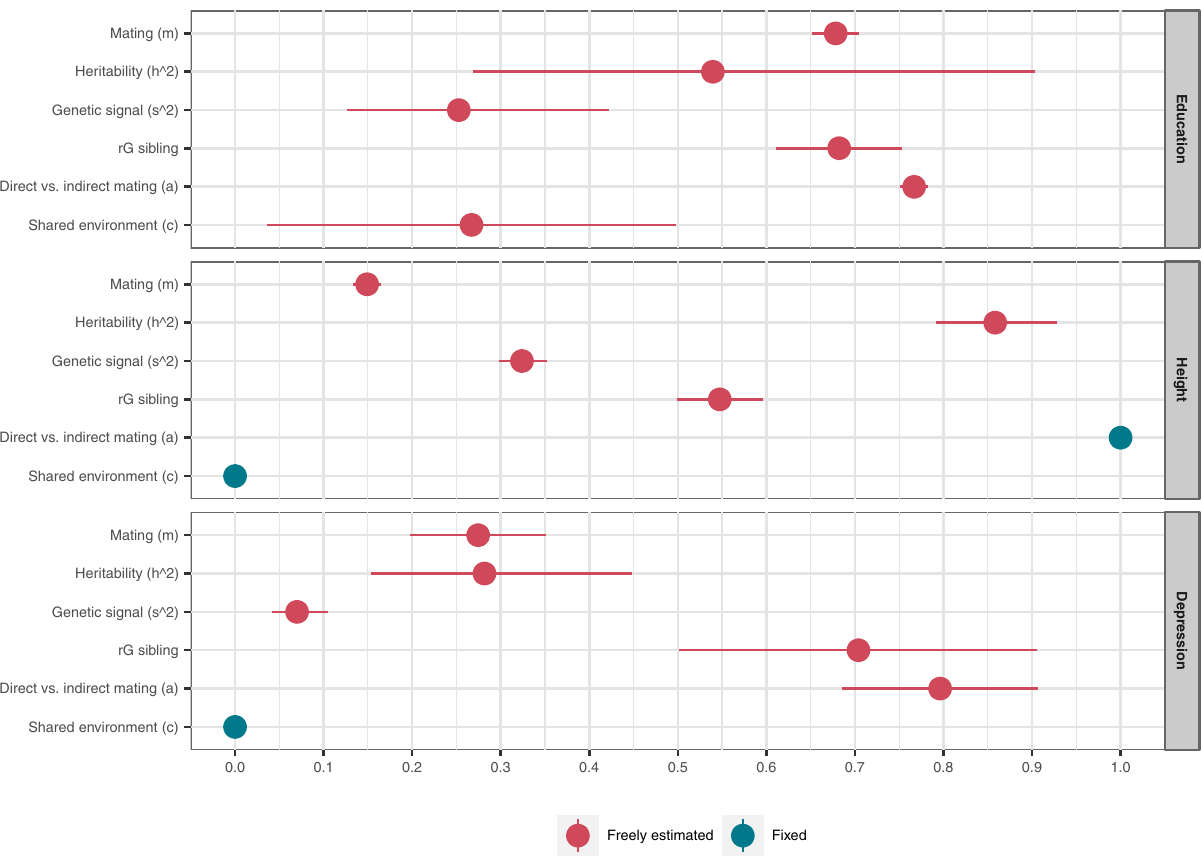
Fig. 3 Parameter estimates. Estimates from the best fi tting rGenSi models, including 95% likelihood-based con fi dence intervals. Values in red are freely estimated and can take any value between 0.00 and 1.00. Values in blue are fi xed ( a = 1 or c = 0) in the best fi tting models. Exact numbers and freely estimated values for all parameters are available in Supplementary Table 6. For height and depression, there are no effects of shared environment ( c = 0). For height, mating is fully based on the measured height ( a = 1), whereas for education and depression, couples assort on a correlated phenotype. rG sibling = correlation between siblings ’ latent genetic factors. Based on genotype data from n = 26,681 complete pairs of partners, n = 2,170 complete sibling pairs, n = 3,905 complete in-law pairs, and n = 1,763 complete co-in-law pairs, and phenotype data from n = 63,781 complete pairs of partners, n = 13,455 complete sibling pairs, n = 21,496 complete in-law pairs, and n = 8,699 complete co-in-laws